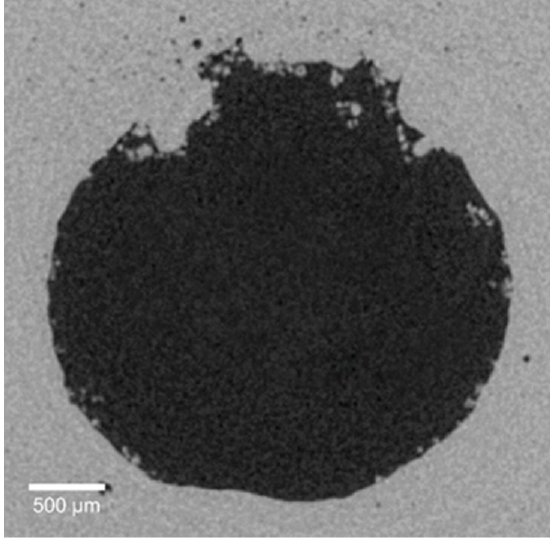
Figure 2. Cropped cross-sectional view of the D nom = 3 mm channel. Selection of Voxel